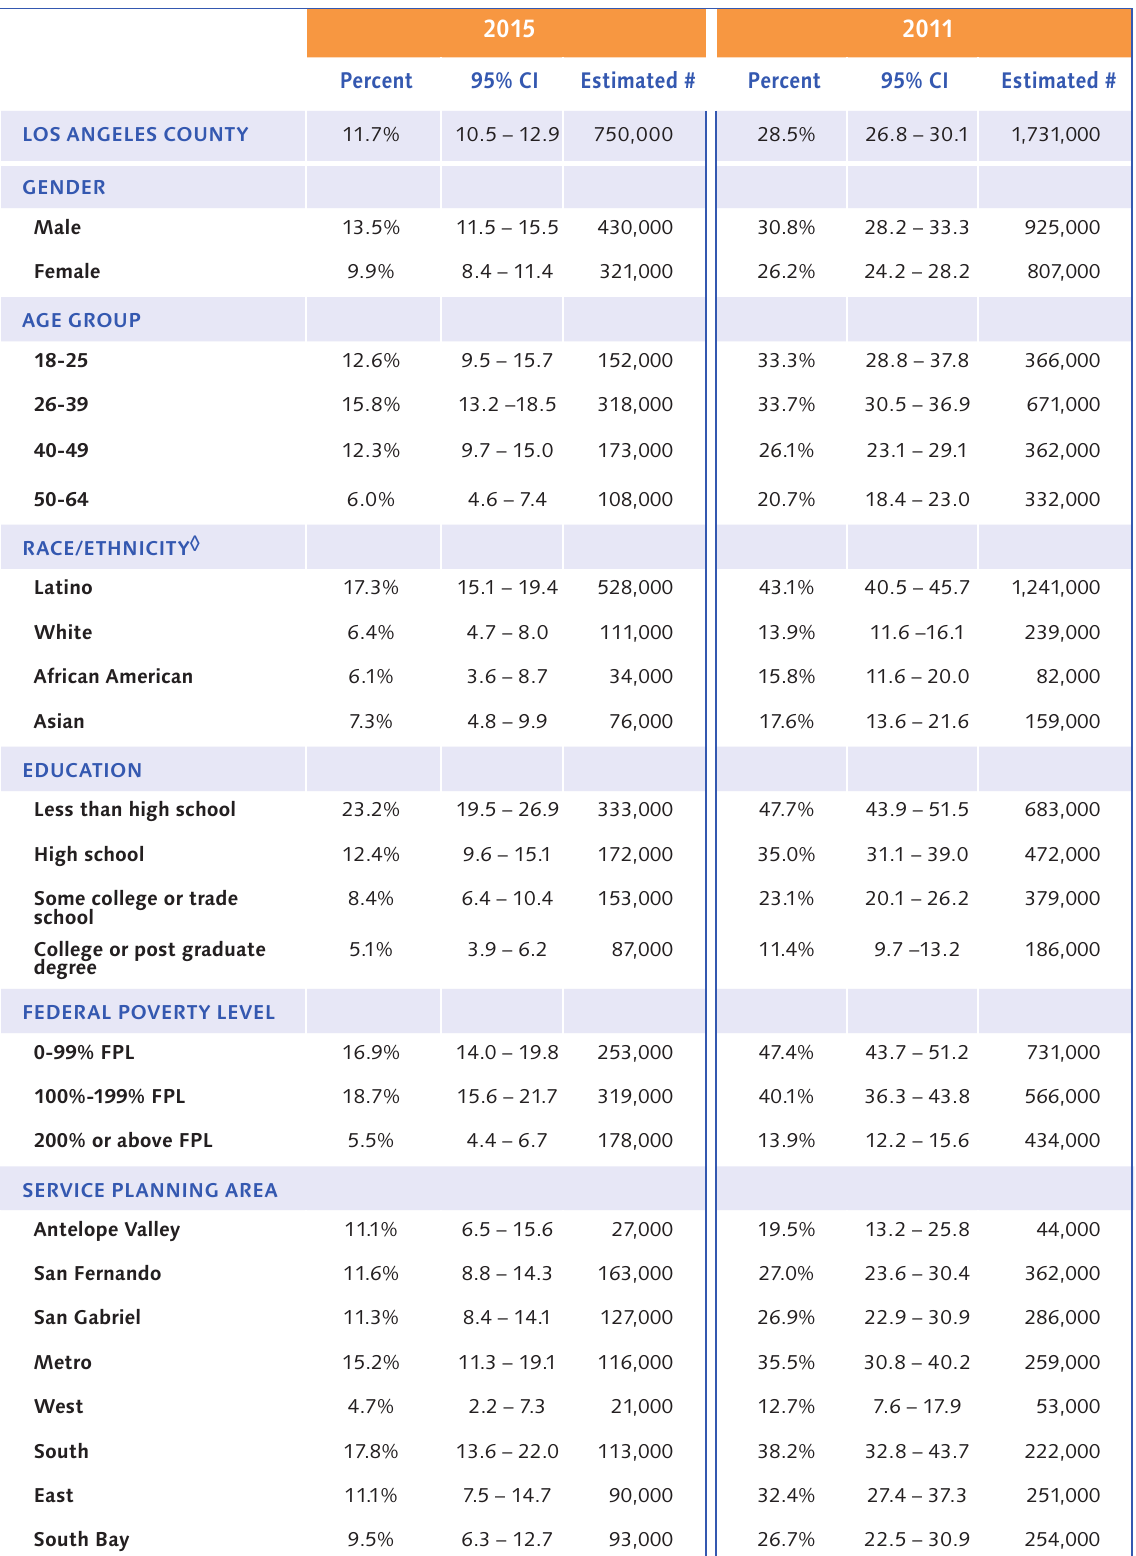
TABLE 1: Percent of Uninsured Adults (18-64 years) , LACHS 2011 &